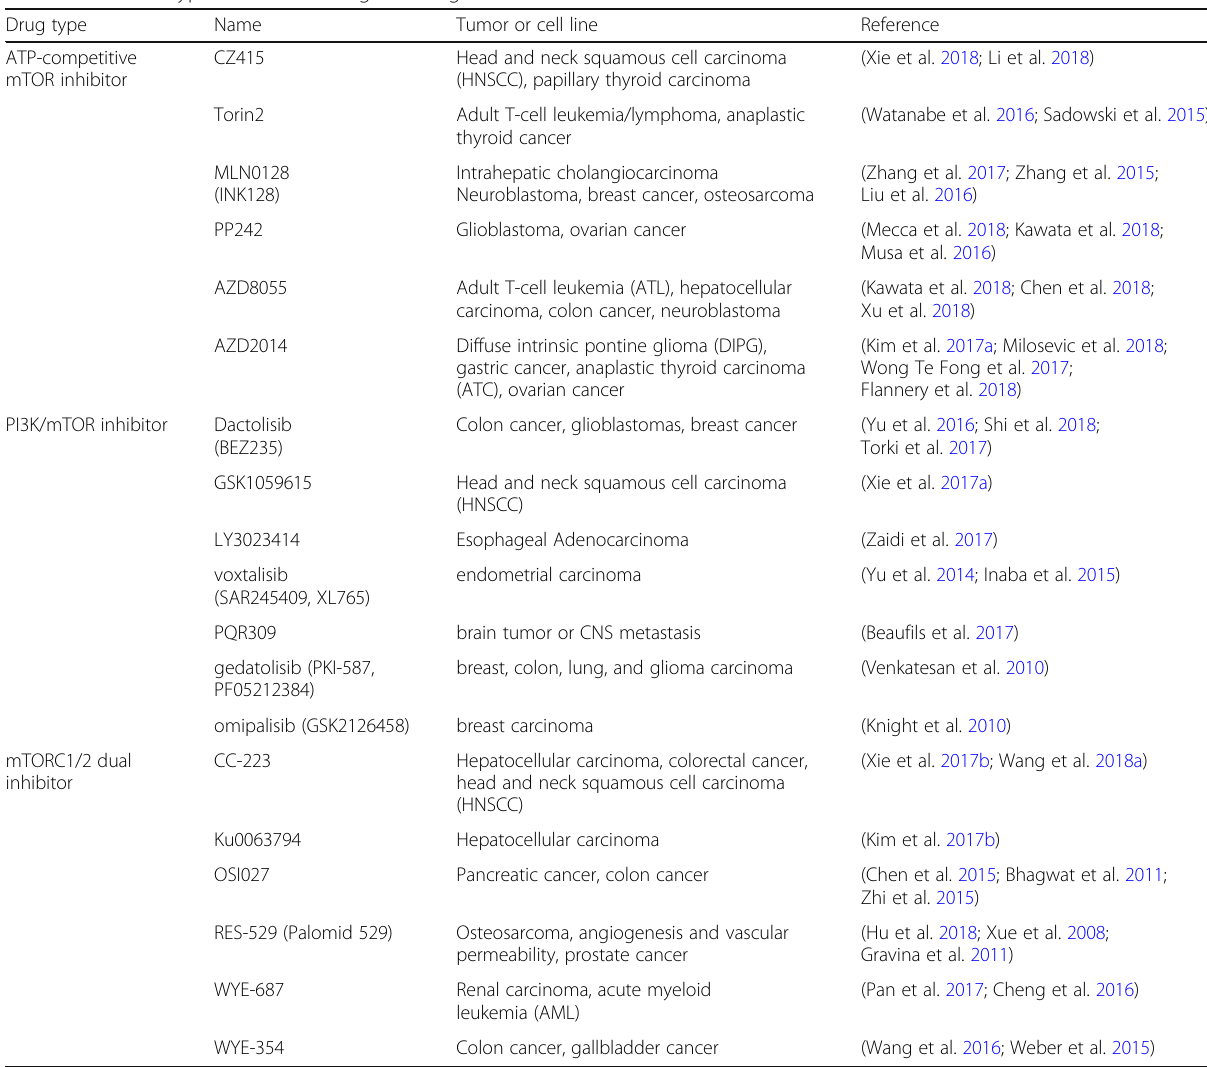
Table 1 Different types of mTORC2 targeted drugs Drug